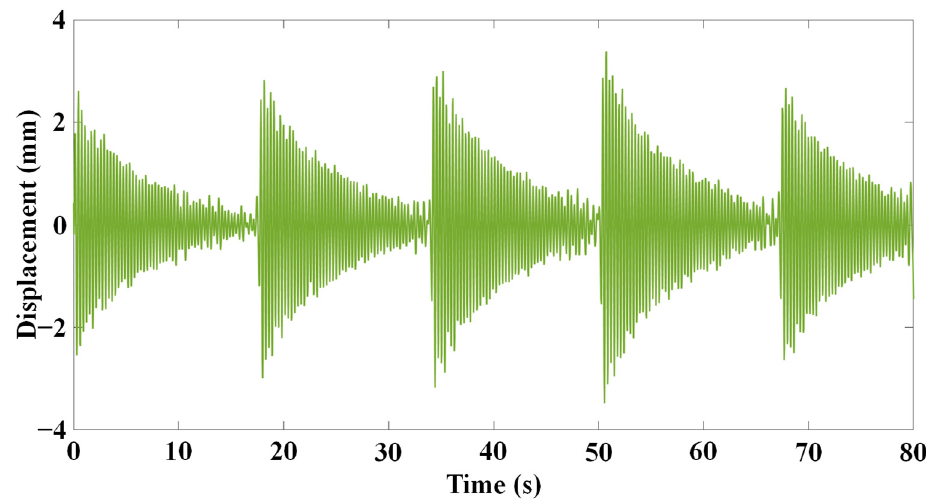
Figure 8. Processed signal of IFT.